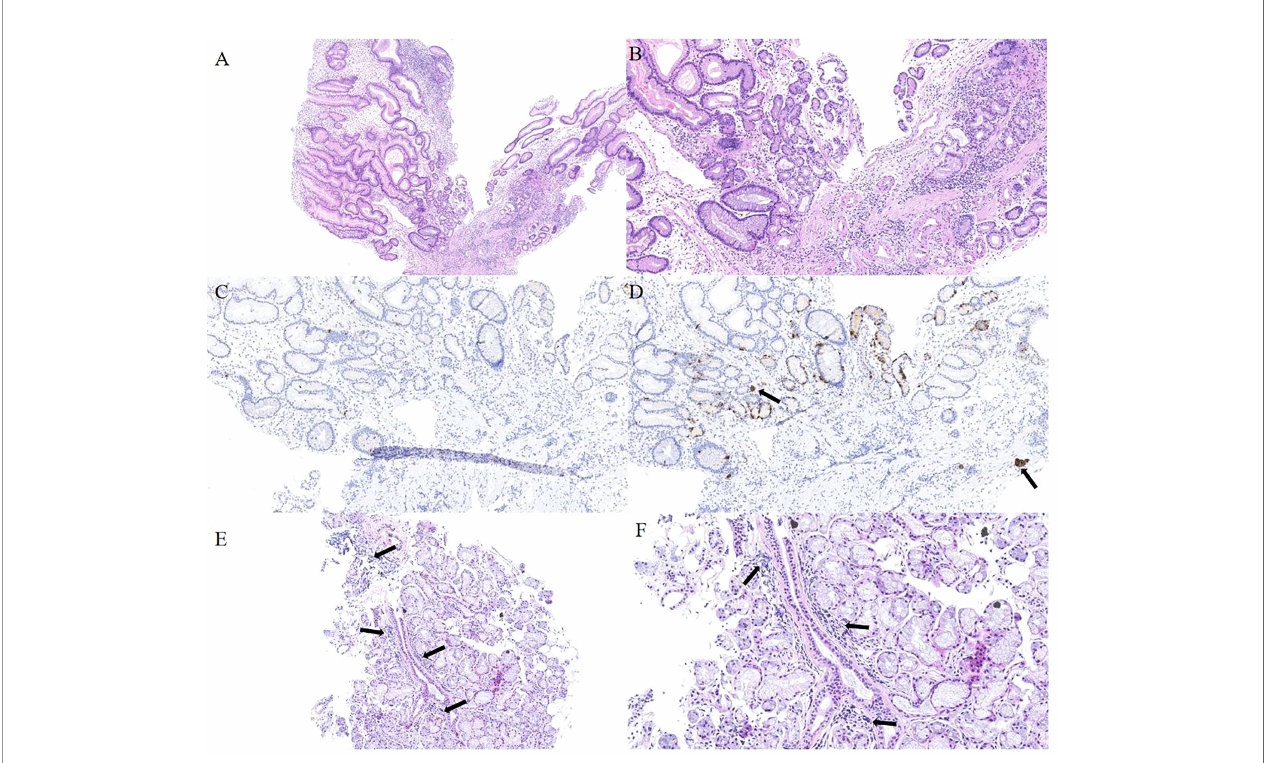
FIGURE 3 | Histopathology of gastric mucosa and labial salivary gland. (A) Hematoxylin and eosin staining (40×) displays a hyperplastic polyp in the corpus. (B) Hematoxylin and eosin staining (100×) displays the background of the hyperplastic polyp: atrophy, intestinal metaplasia and pseudo-pyloric adenylation in the mucosa. (C) Immunohistochemical staining of gastrin is negative in pseudo-pyloric gland. (D) Staining with anti-chromogranin antibodies (CgA) (100×) depicts dark brown endocrine cells (arrow). (E) Hematoxylin and eosin staining (100×) displays no obvious atrophy in the acinus of the labial salivary gland, but small and numerous foci of lymphocytic aggregation was observed (arrow). (F) The arrow indicates the squeeze of the